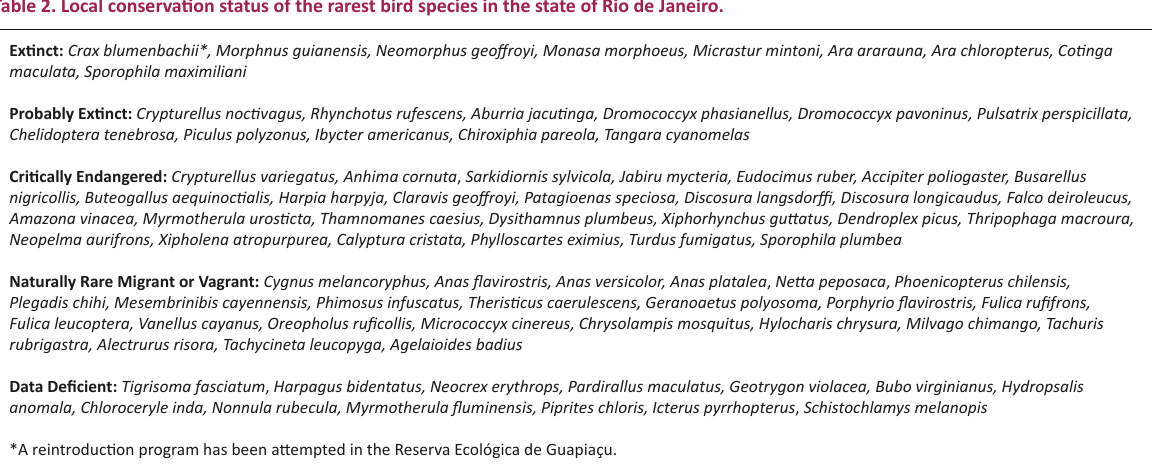
Table 3. Number of species in each trophic guild and type of habitat by local conservation status of the rarest birds in the state of Rio de Janeiro. Ecological Extinct PExtinct CEnd attributes